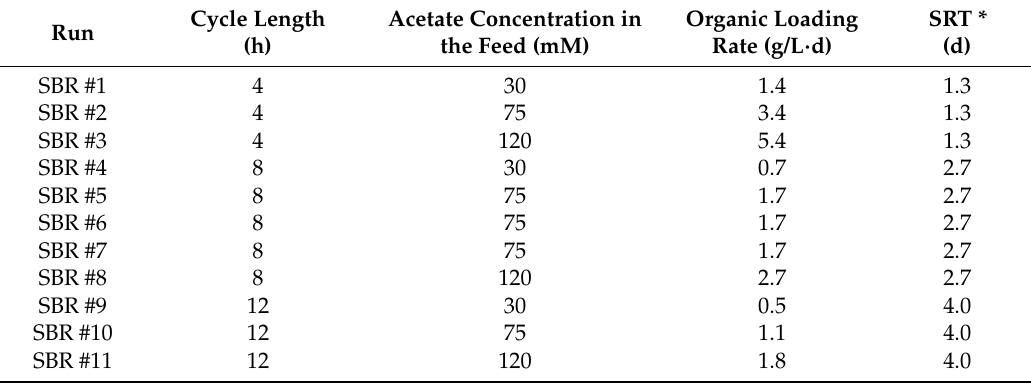
Table 1. Operational conditions in all enrichment SBRs from the experimental